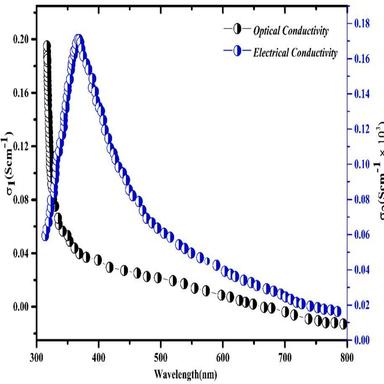
Optical and electrical conductivity against the wavelength of La2SrFe2TiO9.